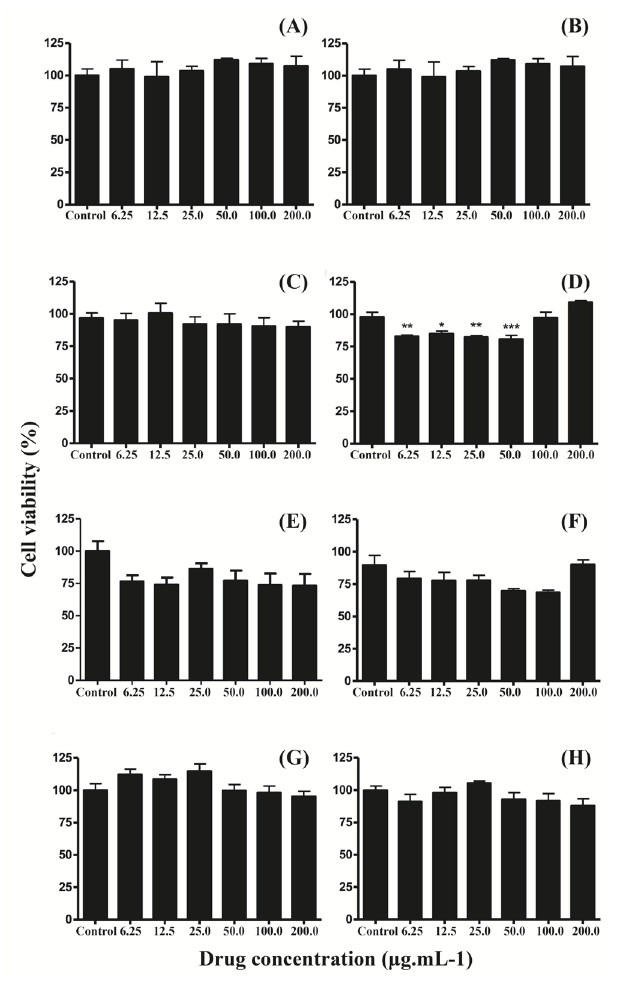
FIGURE 3 - Evaluation of the cytotoxicity at 24 h for (A) blank nanoparticles, (C) NP_DEC10, (e) NP_DEC25, (G) pure DEC; and at 72 h for (B) blank nanoparticles, (D) NP_DEC10, (F) NP_DEC25 and (H) pure DEC. *p<0,05; **p<0,01; ***p<0,001; ****p<0,0001 compared to the control